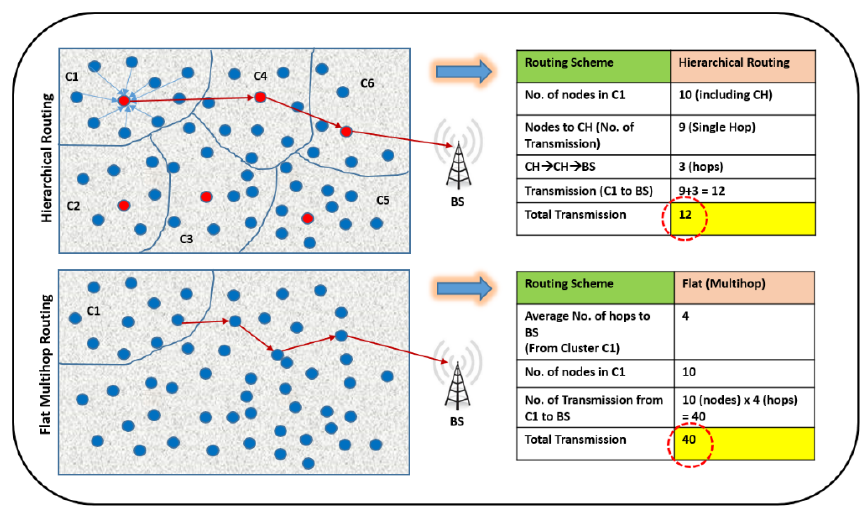
Figure 1. Empirical analysis of hierarchical and flat multihop routing in WSN.